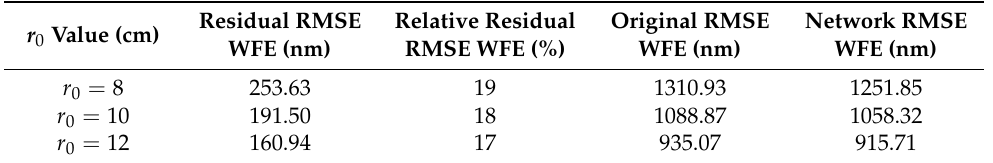
Table 5. Results obtained for the FCN model. Each value is obtained as the mean value over the 3000 samples of the test dataset. In this case, the output of the ANN is directly compared with the simulated image of the phase’s profile by DASP.